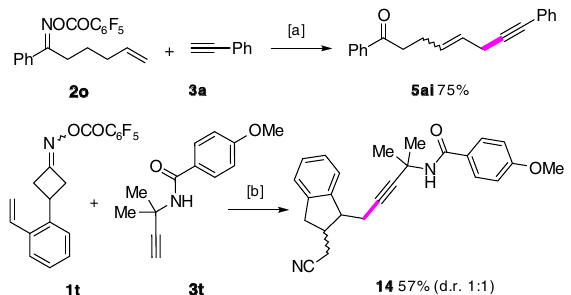
Fig. 6 Control experiments. [a] 2o (0.1 mmol), 3a (0.2 mmol, 2.0 equiv), (CuOTf) 2 ·C 6 H 6 (0.05 equiv), t Bu 3 -TERPY (0.1 equiv), K 2 CO 3 (2.0 equiv), DCE (2.0 mL, c 0.05 M), 45 °C, under nitrogen atmosphere. [b] 1t (0.2 mmol), 3t (0.4 mmol), CuI (0.1 equiv), t Bu 3 -TERPY (0.2 equiv), K 2 CO 3 (2.0 equiv), CH 3 CN (1.0 mL, c 0.2 M), 60 °C, under nitrogen Methods Cu-catalyzed alkynylation of cycloalkanone oxime esters . O -acyloximes 1 (0.2 mmol), terminal alkynes 3 (0.4 mmol, 2.0 equiv), K 2 CO 3 (0.4mmol, 2.0 equiv), CuI (0.02 mmol, 0.1 equiv), and t Bu 3 -TERPY (0.04 mmol, 0.2 equiv) were placed in a dry Schlenk tube. The reaction vessel was evacuated and fi lled up with nitrogen